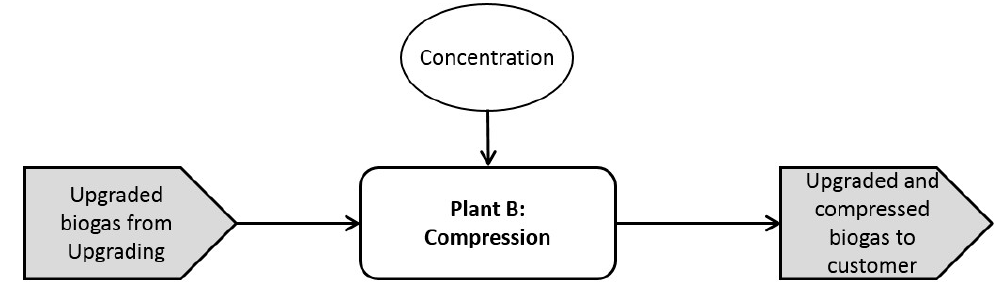
Figure 11. The connection between the sub-process compression and unit processes at biogas plant B.